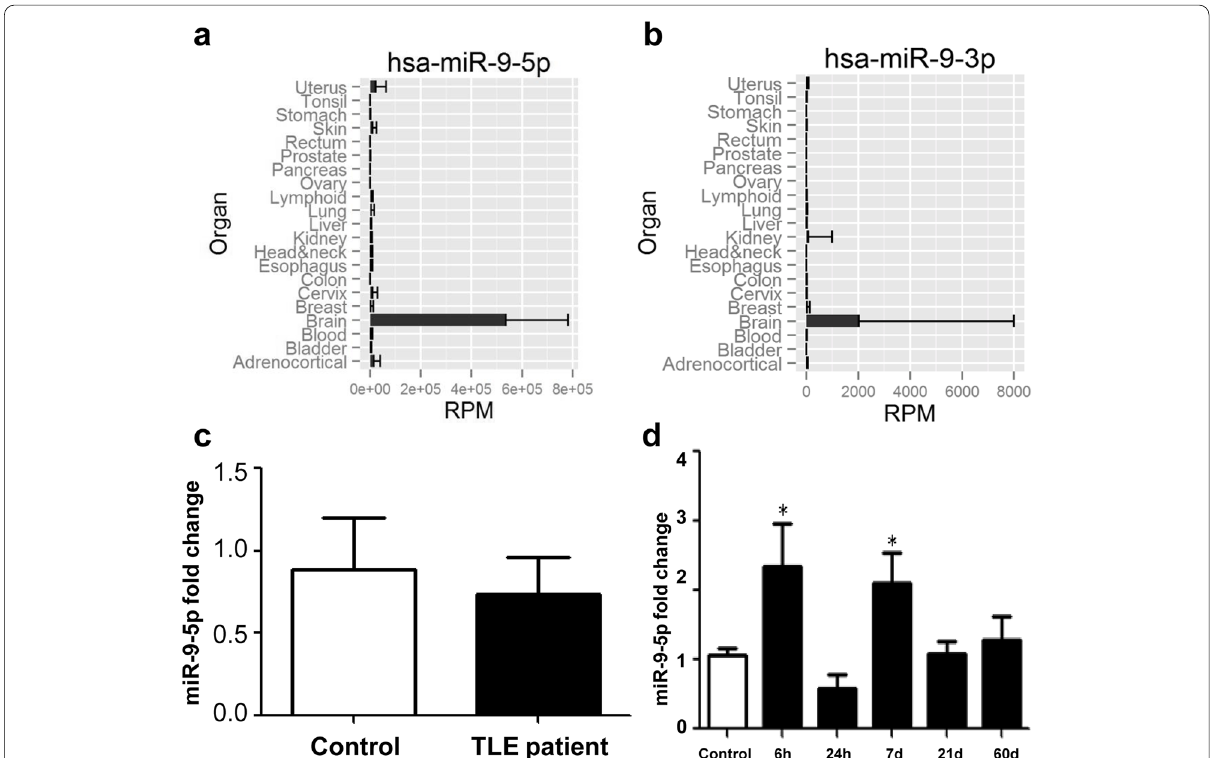
Fig. 1 Expression of miR-9-5p in epileptic and non-epileptic tissues. a Expression of miR-9-5p in human tissue; b Expression of miR-9-3p in human tissue; c Expression level of miR-9-5p in the temporal lobe of TLE patients and controls; d Expression of miR-9-5p in the hippocampal tissues of rats was significantly increased at 6 h and 7 days after SE, compared to the control group (* P < 0.05). RPM, reads per million mapped